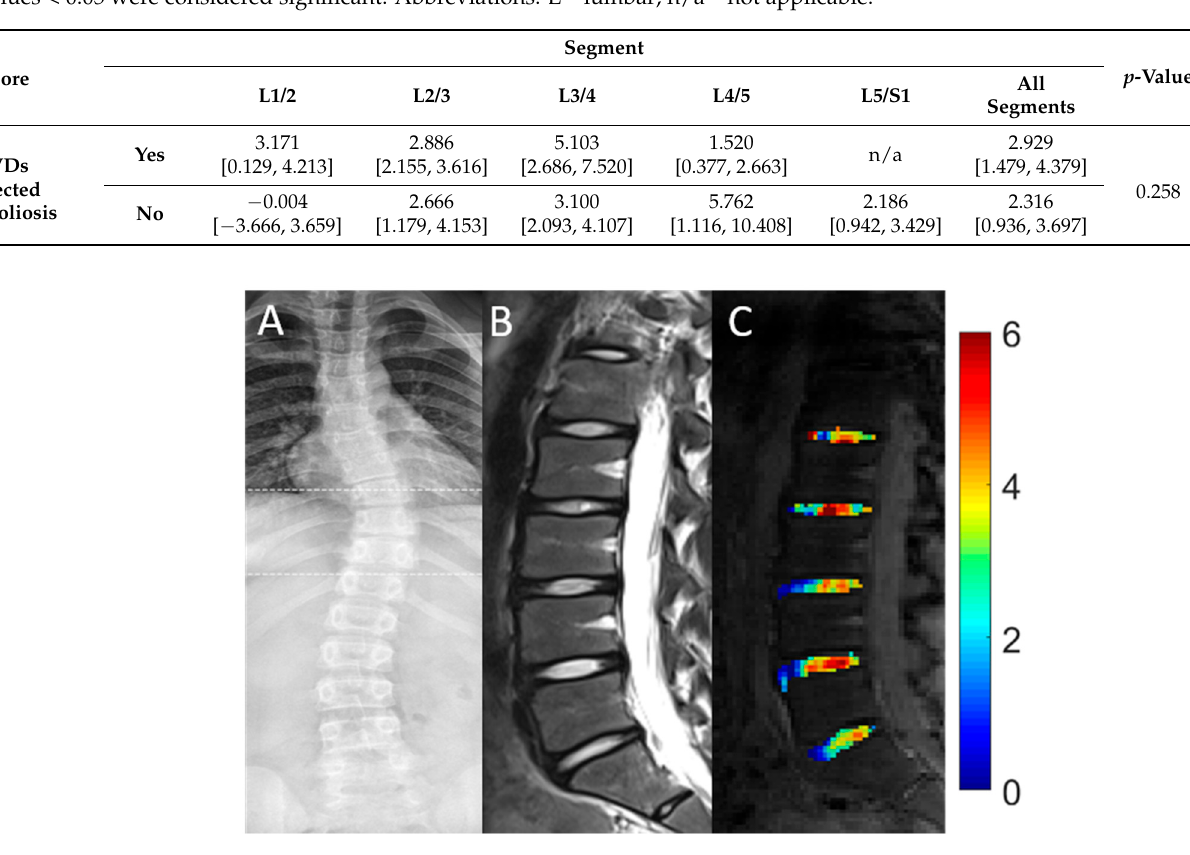
Table 4. Analysis of scoliotic affection on compositional imaging features of lumbar intervertebral discs (IVDs) in AIS patients. Mean glycosaminoglycan chemical exchange saturation transfer (gagCEST) values as a function of scoliotic affection (affected and unaffected IVDs of AIS patients) and IVD segment levels. Using a linear mixed model including a subject-specific intercept, mean values of gagCEST were compared. Data are corrected mean + 95% confidence interval [square brackets] (%) of gagCEST values of the nucleus pulposus (NP). The covariates were corrected for an age of 23.1